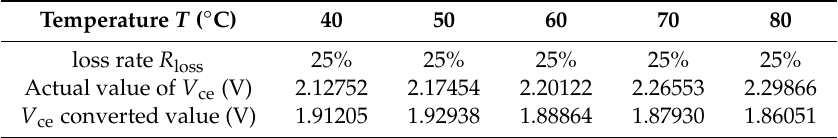
Table 8. Comparison of the data before and after the junction temperature conversion.